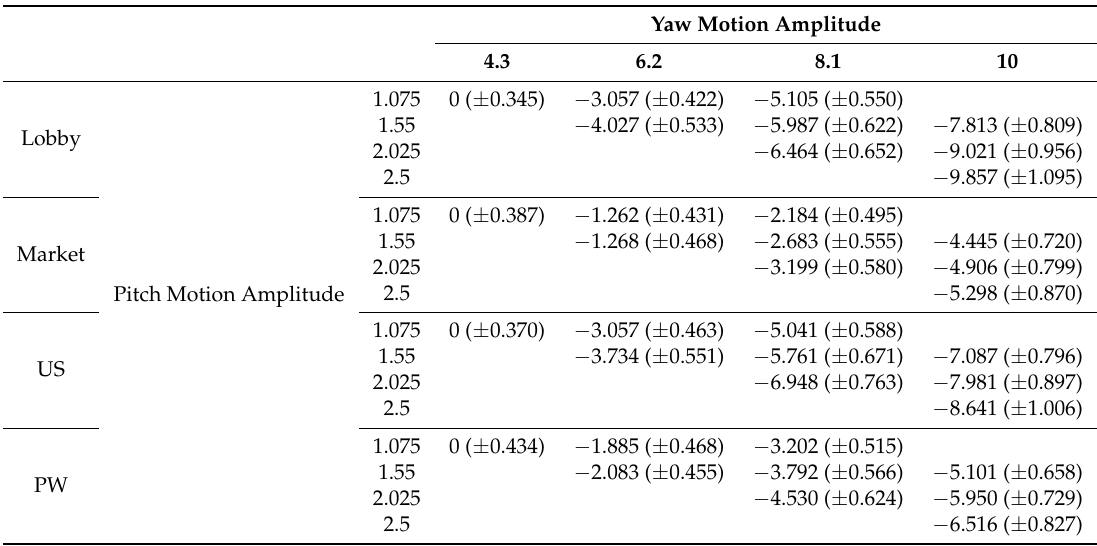
Table 2. Bradley–Terry scores of all